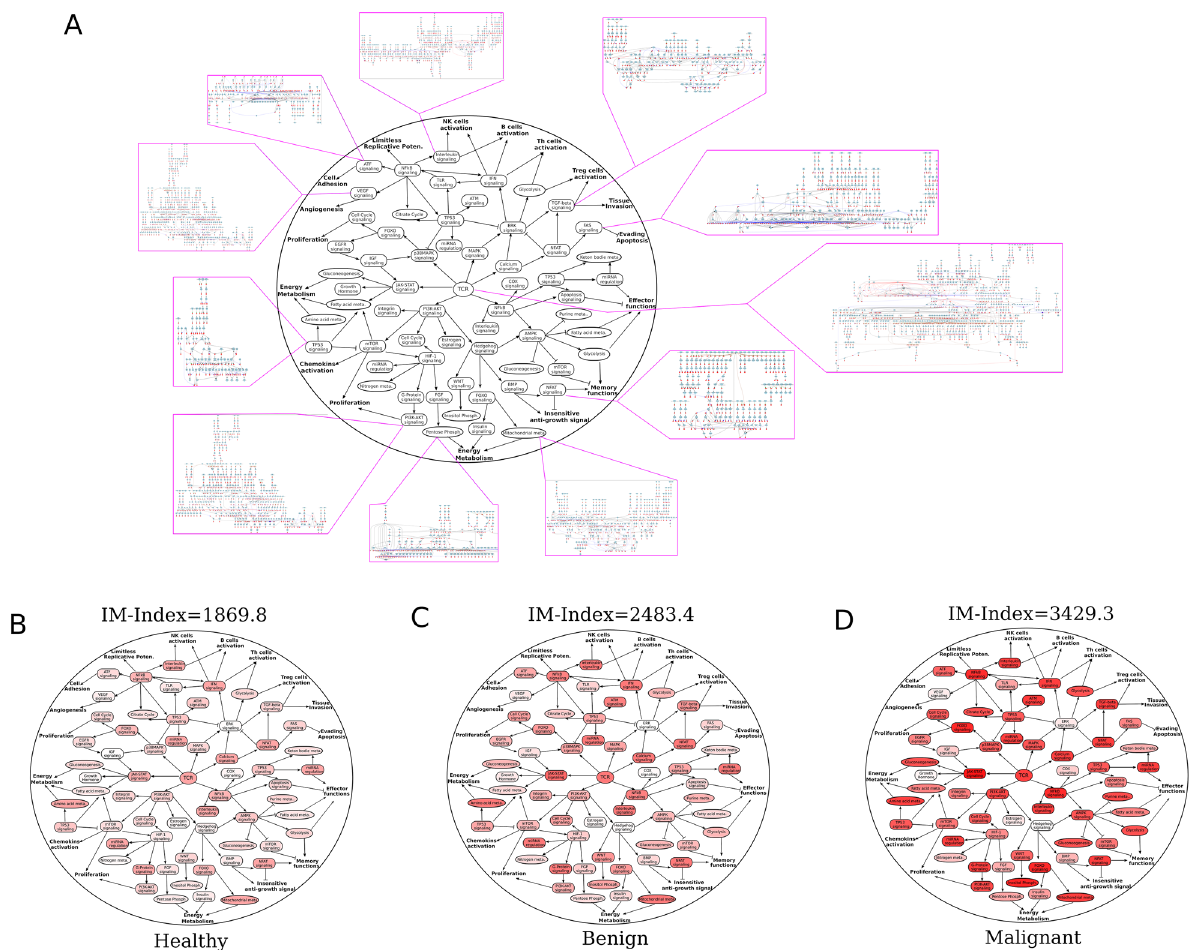
Figure 3. Schematic Immune-related Pathway Interaction Map and IM-Index. ( A ) A simplified overview of the abstract signaling interaction and crosstalk between different signaling and metabolic pathways in the artificial intelligent (AI) model. The map is termed PIML (pathway interaction map of leukocyte). Each element symbolizes a corresponding pathway containing up-, middle-, and downstream components including gene, RNA, protein, compound, and complex. ( B – D ) three PIMLs visualize these three groups with median IM-Index